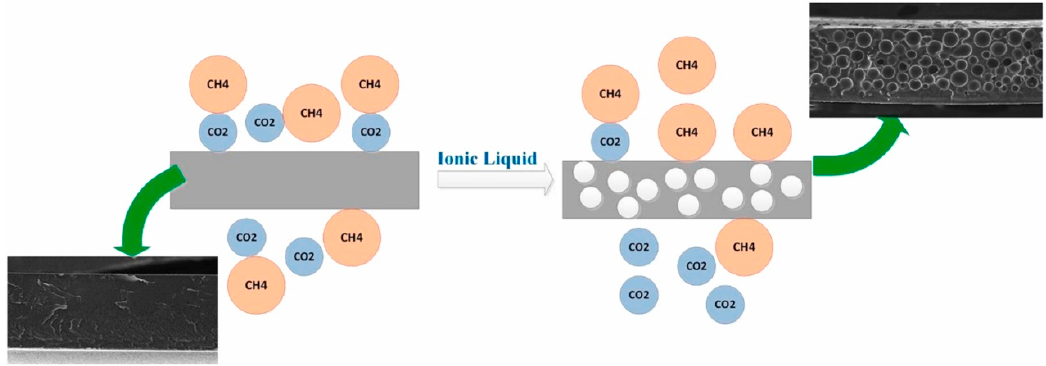
Figure 5. Exhibition of CO 2 separation from CO 2 /CH 4 mixture by using polysulfone/1-ethyl-3-methylimidazolium tetrafluoroborate composite membrane [6].